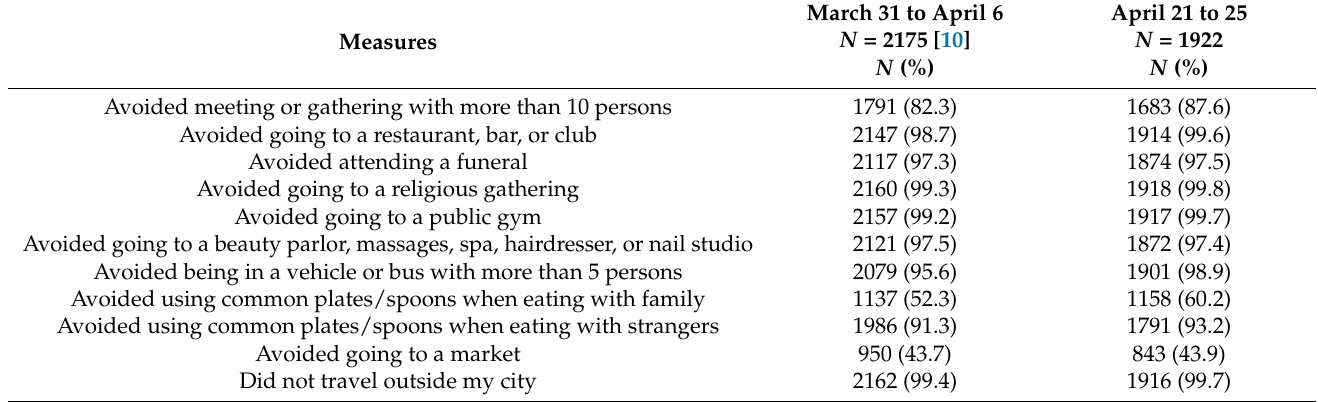
Table 6. Adherence to community COVID-19 preventive measures in the last seven days.